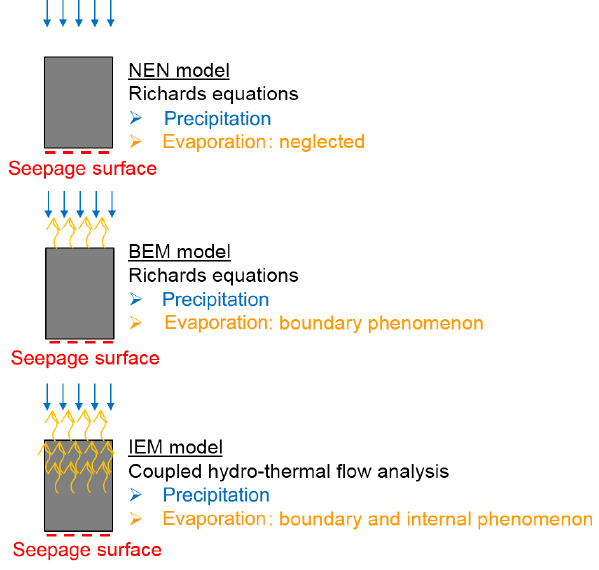
Figure 8. Model schemes adopted for early warning